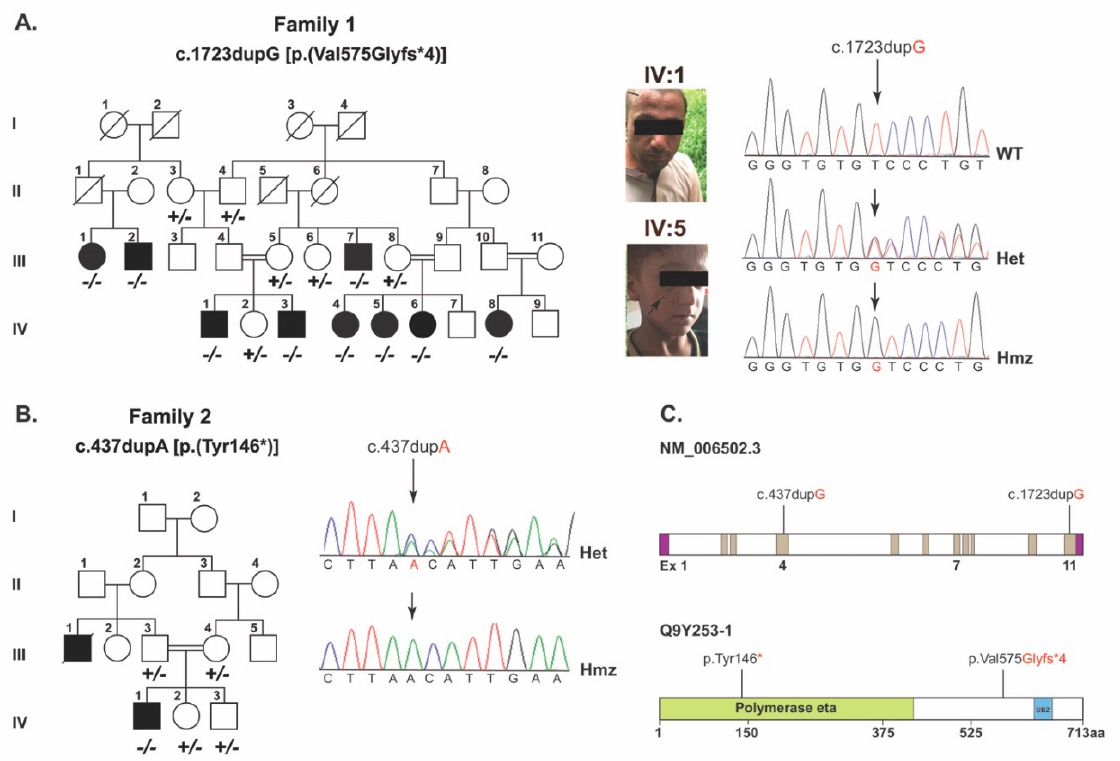
Figure 1. Pedigrees of the two unrelated families affected with xeroderma pigmentosum. ( A ) Pedigree of family 1 along with their photographs and chromatograms generated with Sanger sequencing data. All the patients were offspring of first-cousin marriages. The patients have lentigines on the exposed parts of the body, especially face and neck. ( B ) Family 2 pedigree and sequencing chromatograms. Filled symbols represent affected individuals, double lines represent consanguineous marriages. Generation numbers are shown as I, II, III and IV. ( C ) Schematic representation of POLH gene and protein structure. The identified variants (c.437dup A and c.1723dupG) were present in POLH exon 4 and 11, respectively. Polymerase eta domain is involved in translesion synthesis; however, UBZ (Ubiquitin-Binding Zinc Finger) is necessary for the polymerase engagement to the impeded replication machinery in